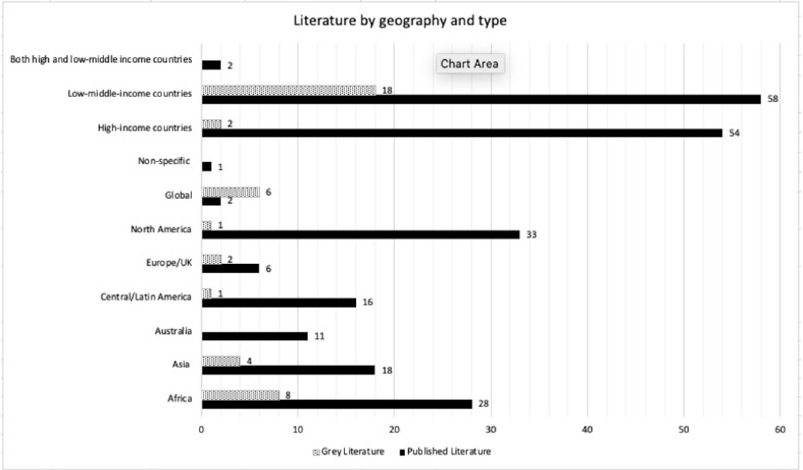
Fig 4. Literature by geography and type included in the peer-reviewed and grey